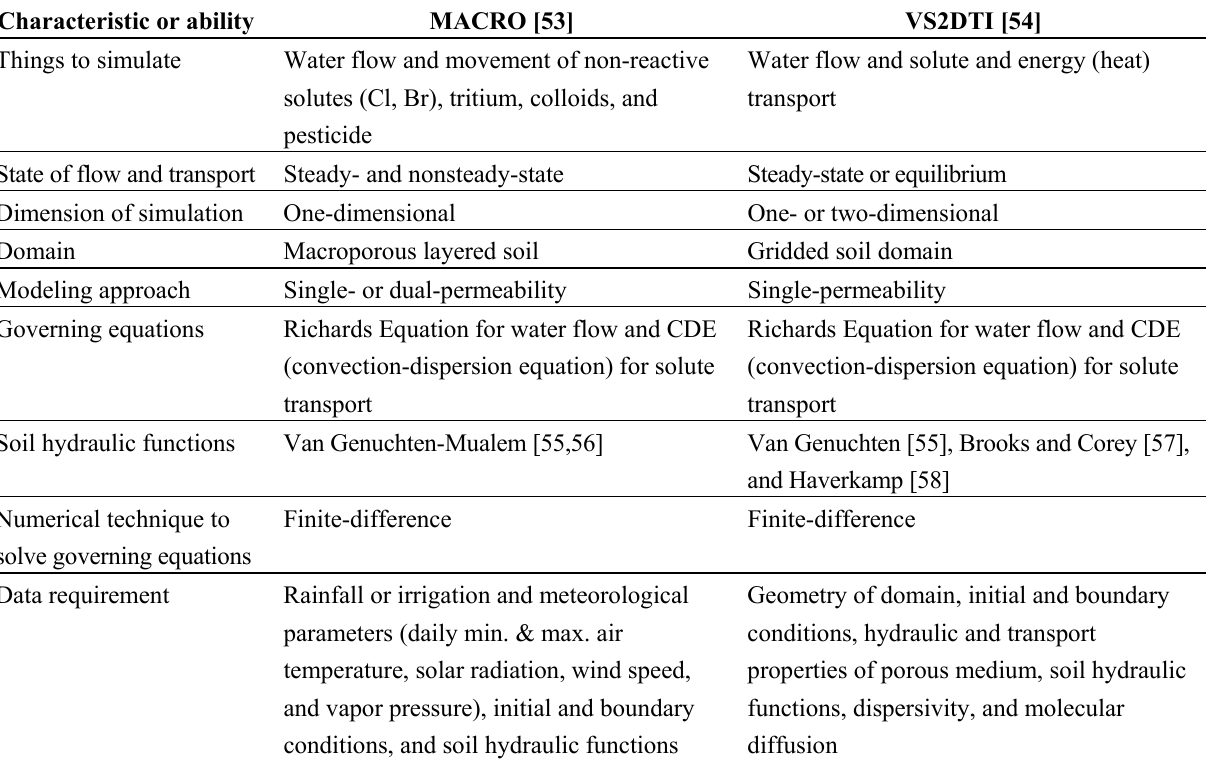
Table 3. Comparison of model characteristics and/or